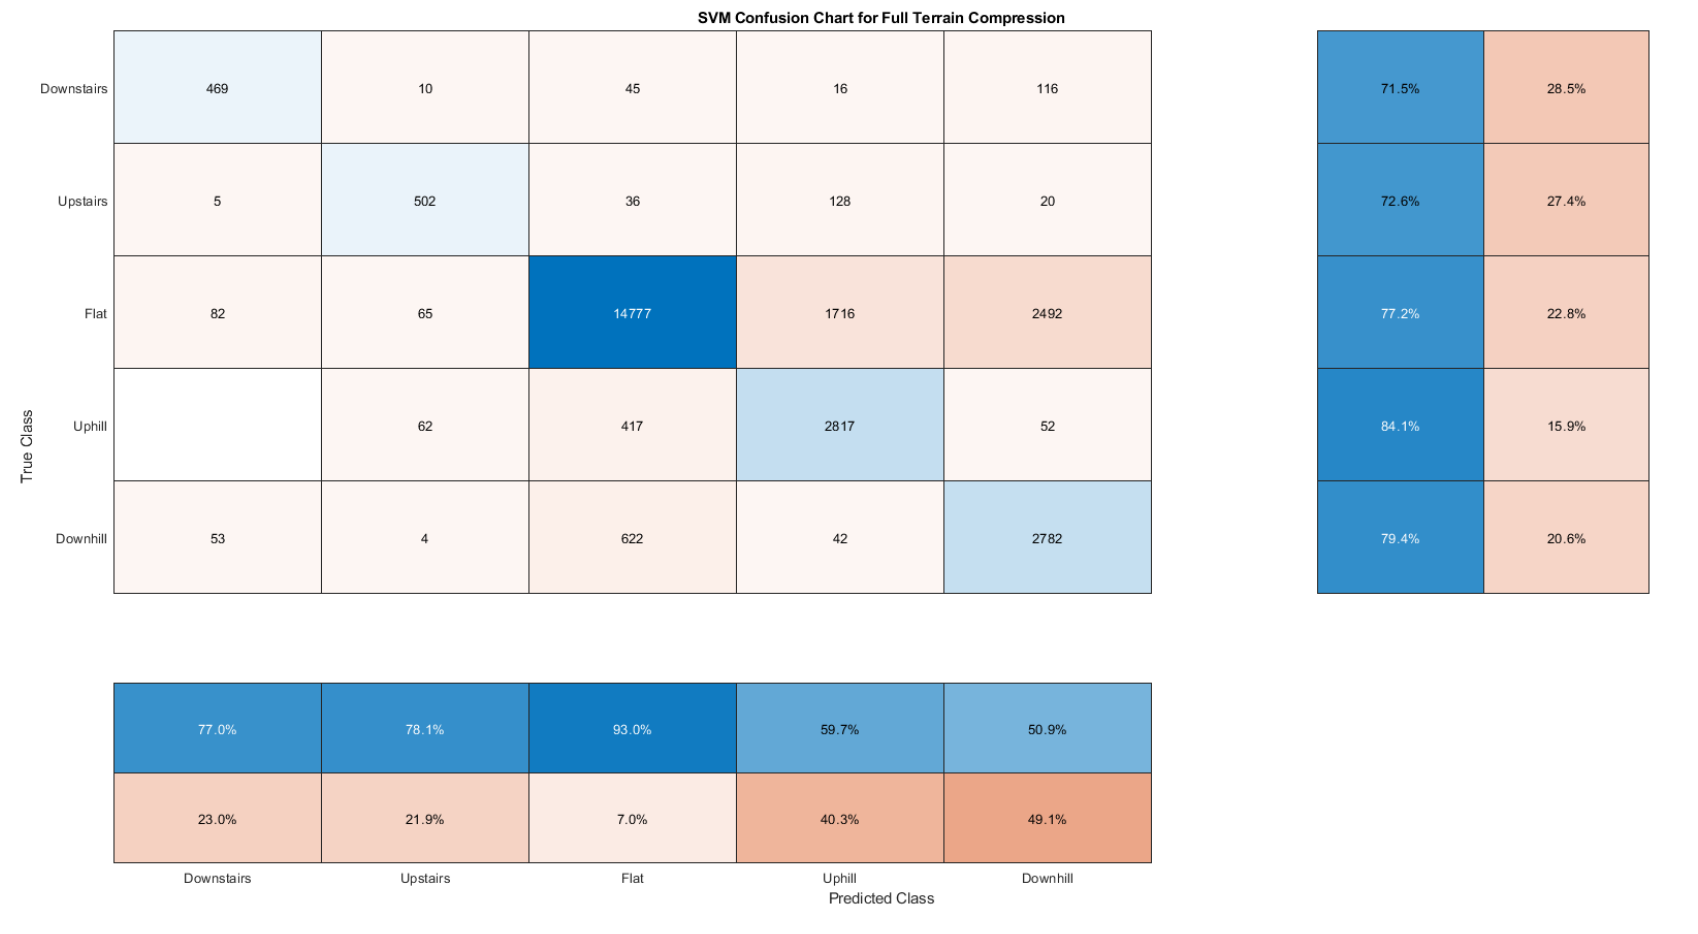
Figure A1. Support Vector Machine Confusion Chart for Level 1 label